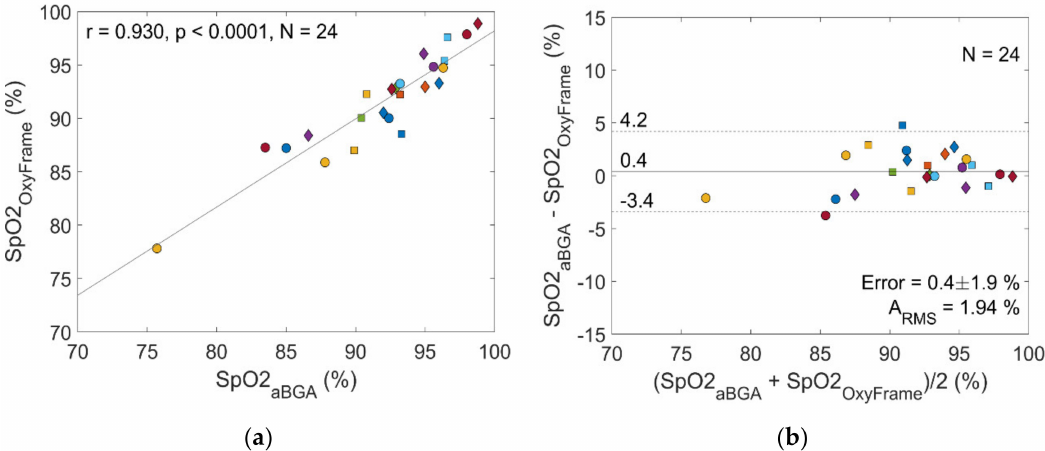
Figure 6. Performance of the OxyFrame device compared to arterial blood gas analysis in patients. ( a ) Correlation plot S p O 2 measurement by OxyFrame versus arterial blood gas analysis (aBGA); ( b ) Bland-Altman plot S p O 2 measurement by OxyFrame versus aBGA. Measurements of the same patient have the same color and